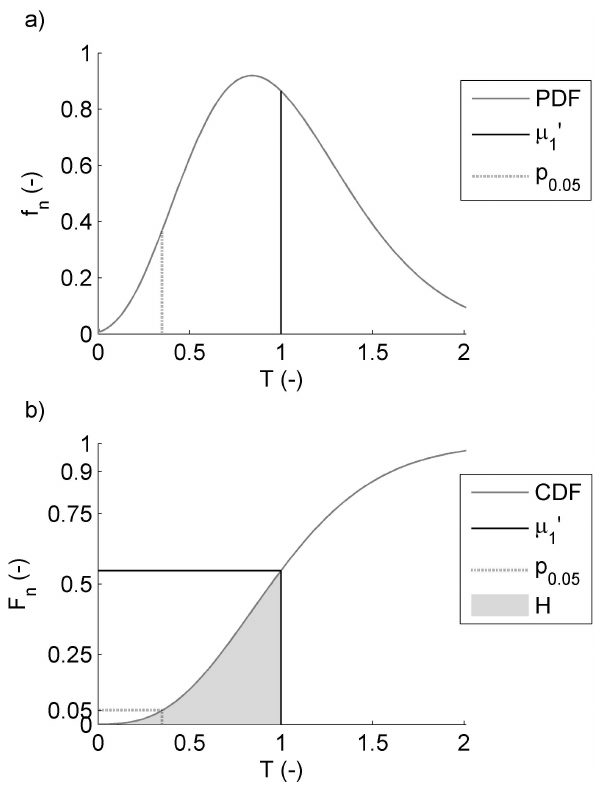
Fig. 1. The PDF (a) and CDF (b) of an example BTC taken from Garr´e et al. (2010) illustrating how the normalized first temporal 0 moment, µ , the normalized 5%-arrival time, p 0 . 05 , and the hold- 1 back, H , are